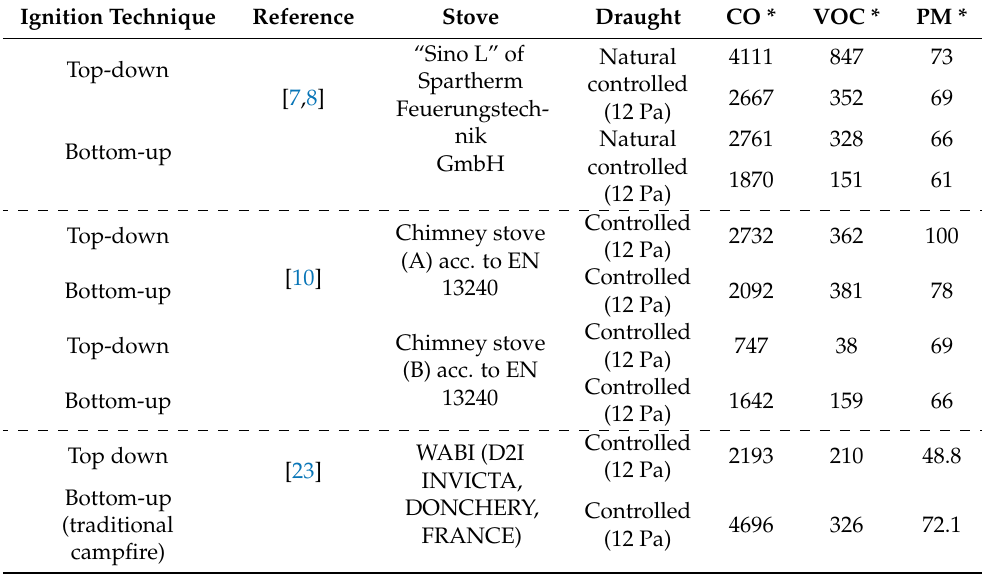
Table 1. Average results of three tests according to top-down and bottom-up ignition techniques. Ignition